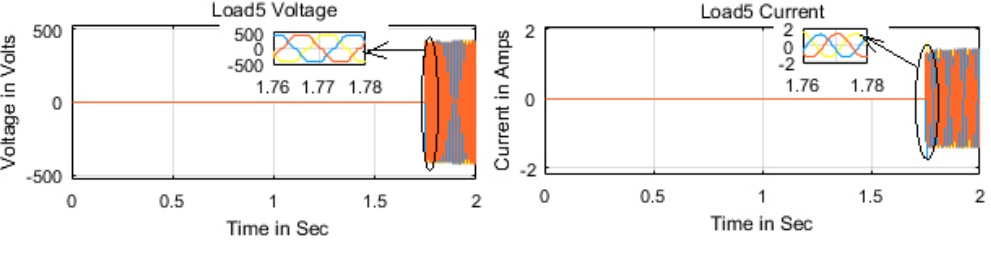
Figure 27. Load5 Voltage &